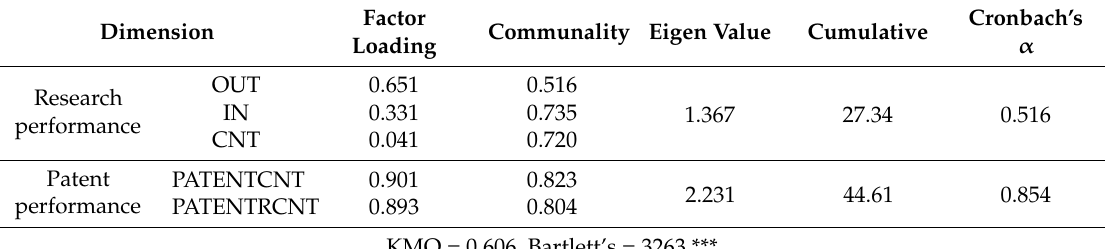
Table 3. The factor